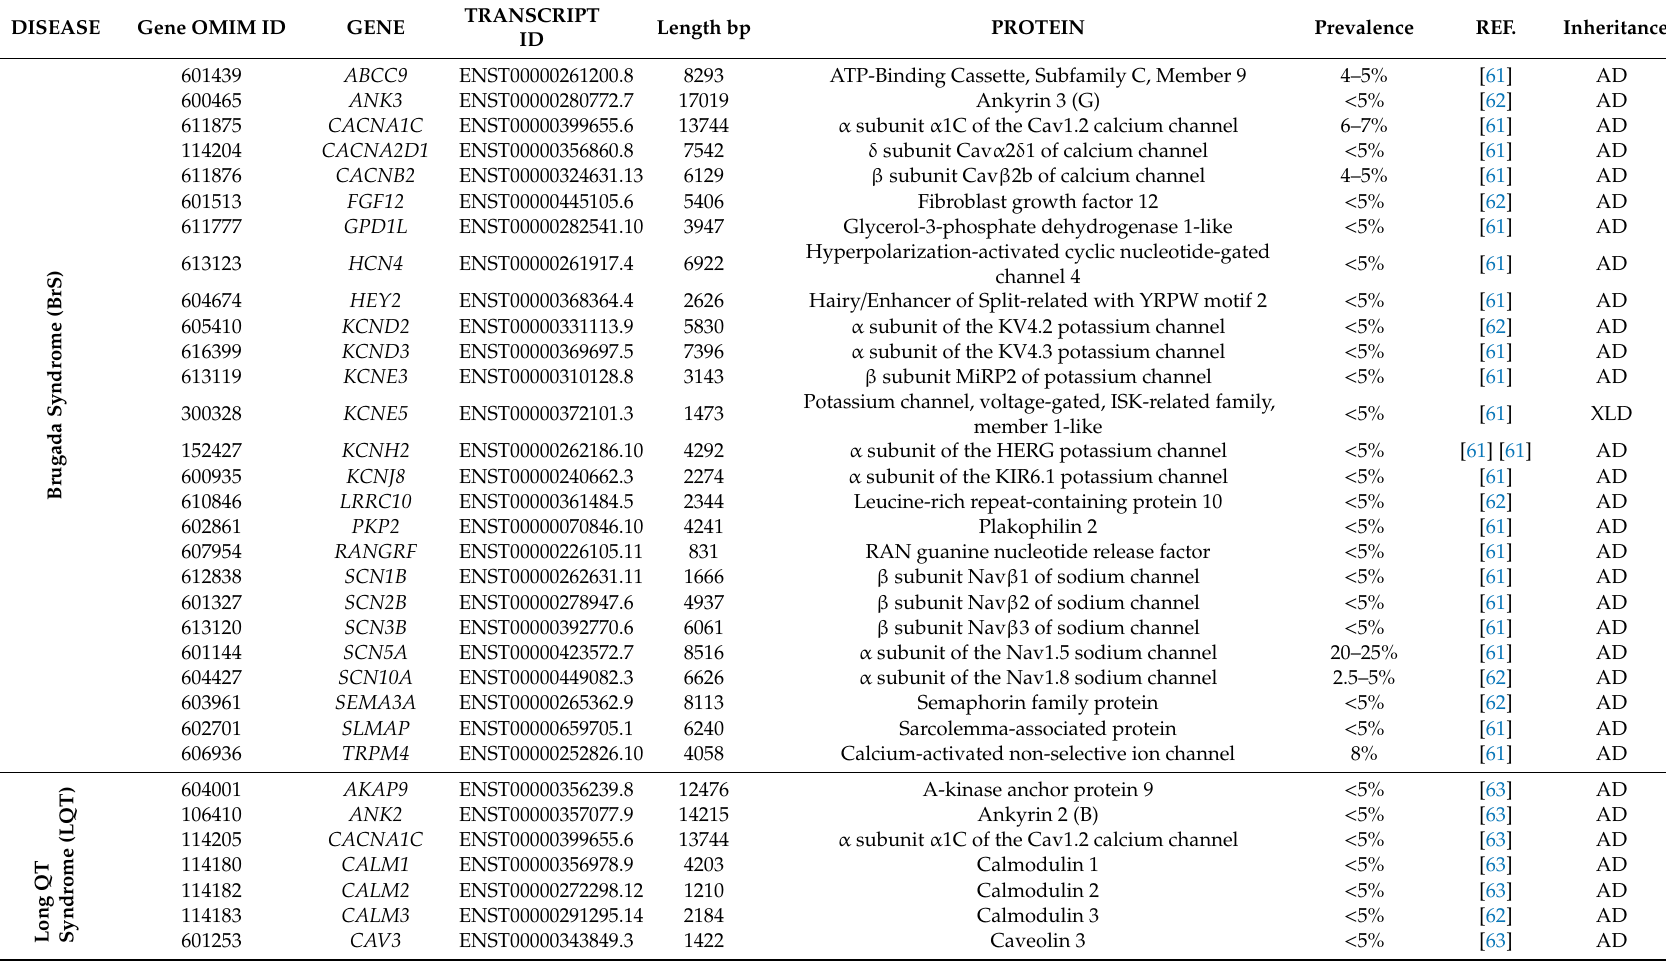
Table 1. Major and Minor Genes Associated to Inherited Channelopathies and